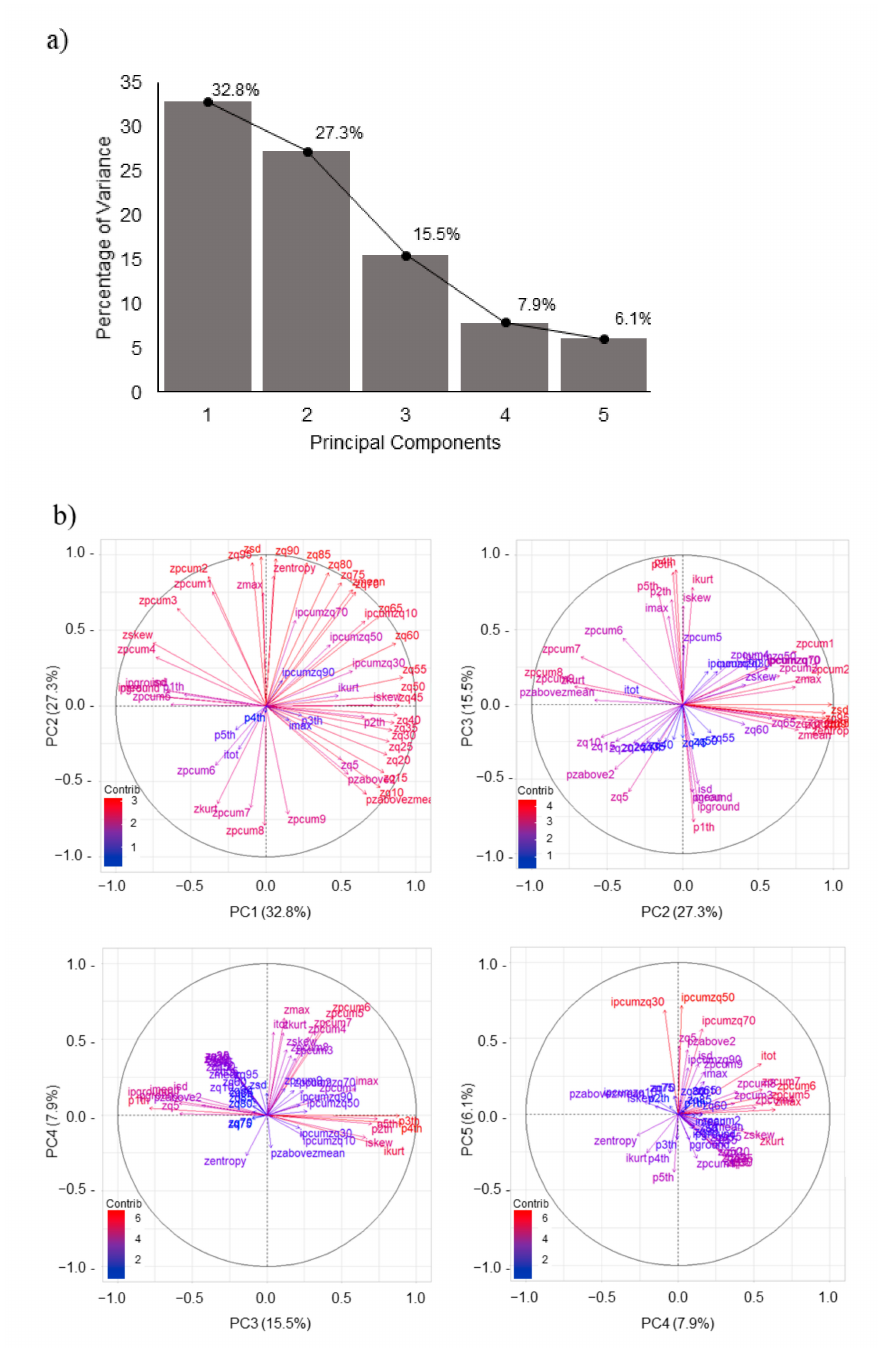
Figure 4. ( a ) First five principal components (PCs) and the percentage of variance explained by each one. ( b ) Projection of Table 5. PCs and the LiDAR